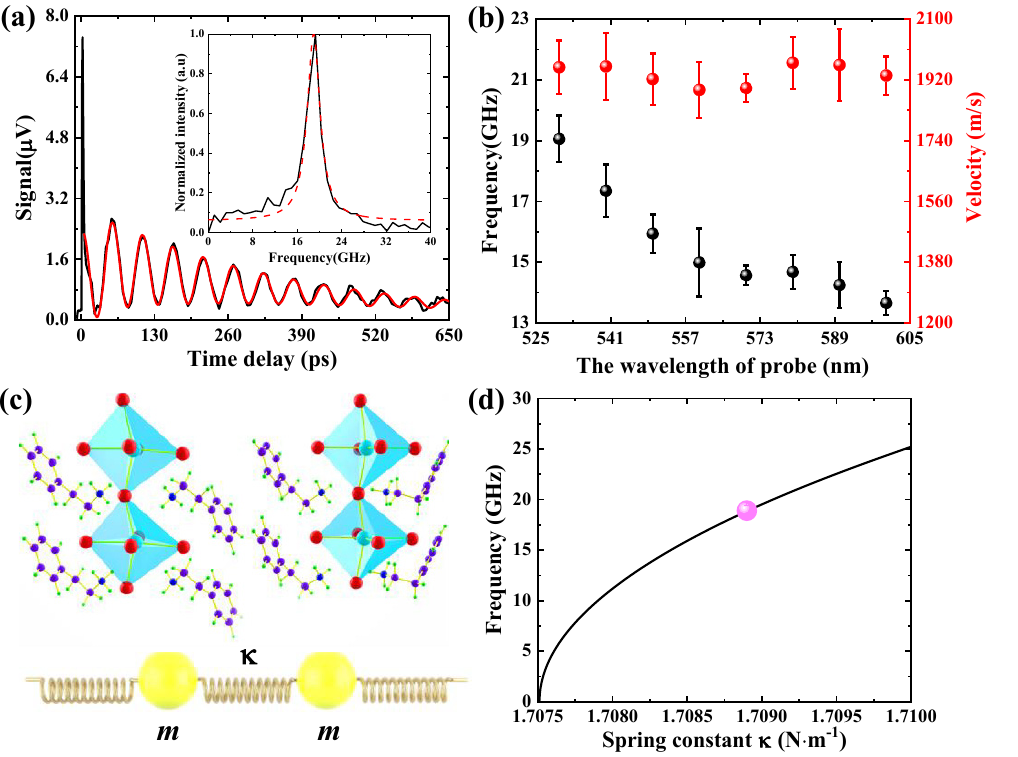
Figure 2: Coherent acoustic phonons in perovskites. (a) Transient reflectivitytracefora singleAu NPLon(PEA) 2 PbI 4 fi lmwhereBrillouinoscillations wereobserved withpumpandprobewavelengths of 800and530nm,respectively.Theredisa fi ttothecurvewhichgivesphononlifetimeof300ps.InsetshowsthefastFouriertransform(FFT)spectrum of the oscillations together with a Lorentz curve fi tting in red. (b) Probe wavelength dependent Brillouin oscillation frequency and the calculated sound wave velocities with average value of ν = 1937 ± 31 m/s (error stands for standard deviation). (c) Schematic illustration of the bead-spring model in (PEA) 2 PbI 4 fi lm. (d) Calculated spring constant k versus acoustic phonon frequency. The marker is the experimental measurement in (PEA) 2 PbI 4